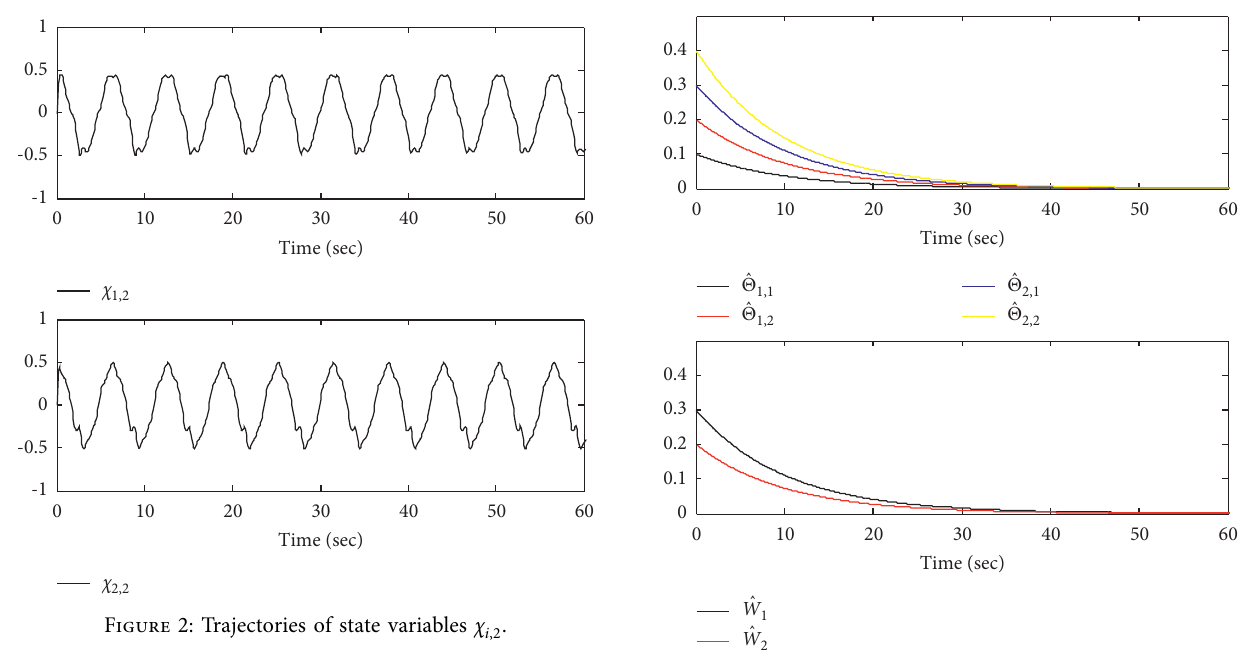
Figure 4: Trajectories of adaptive parameters 􏽢 Θ